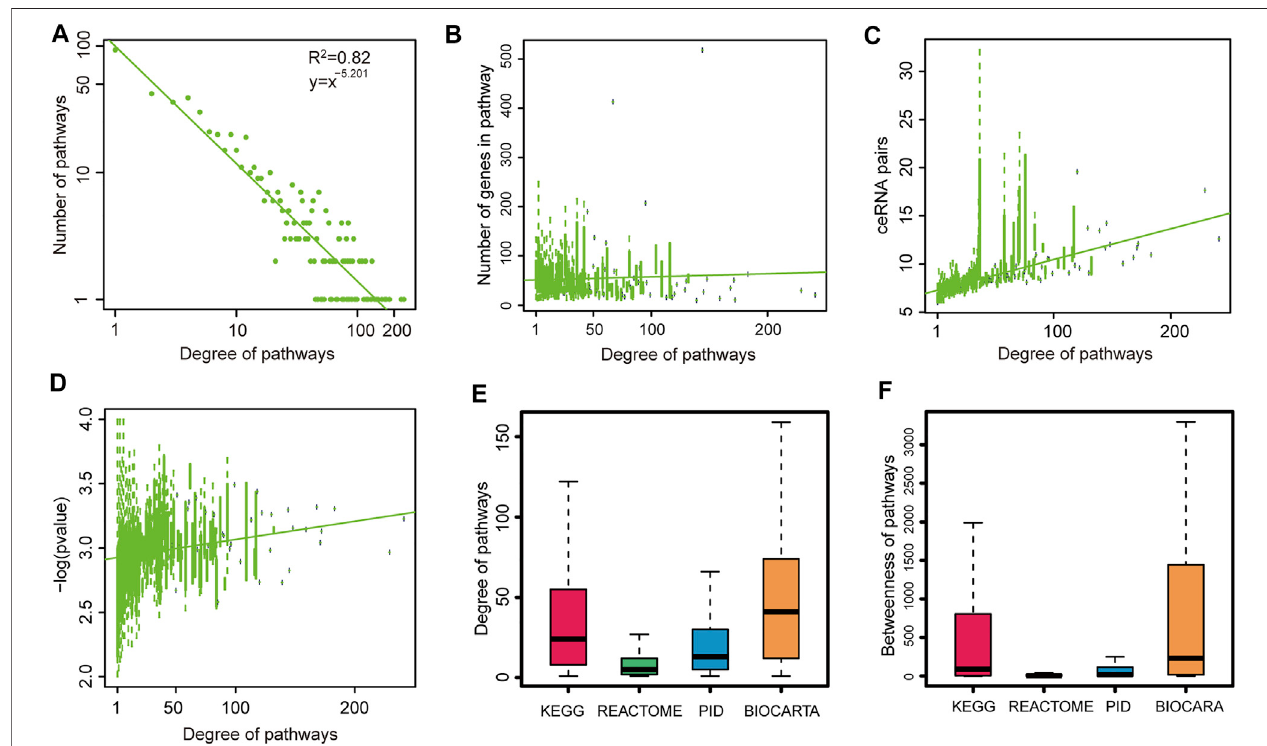
FIGURE 2 | Global topological features of pathway crosstalk networks. Here, we show topological features of one network (GSE1145) and others are shown in Supplementary Figures. (A) Degree distributions of network. (B) Pathways with high degree encompassed more genes than others. (C) Pathways with high degree occupiedmoreceRNApairsthanothers. (D) Pathwayswithhighdegreehadmorecrosstalkactivitiesthanothers.Wereplacedthe p value=0with p value=0.0001. (E) Degree distributions of four pathway databases. (F) Betweenness distributions of four pathway databases.